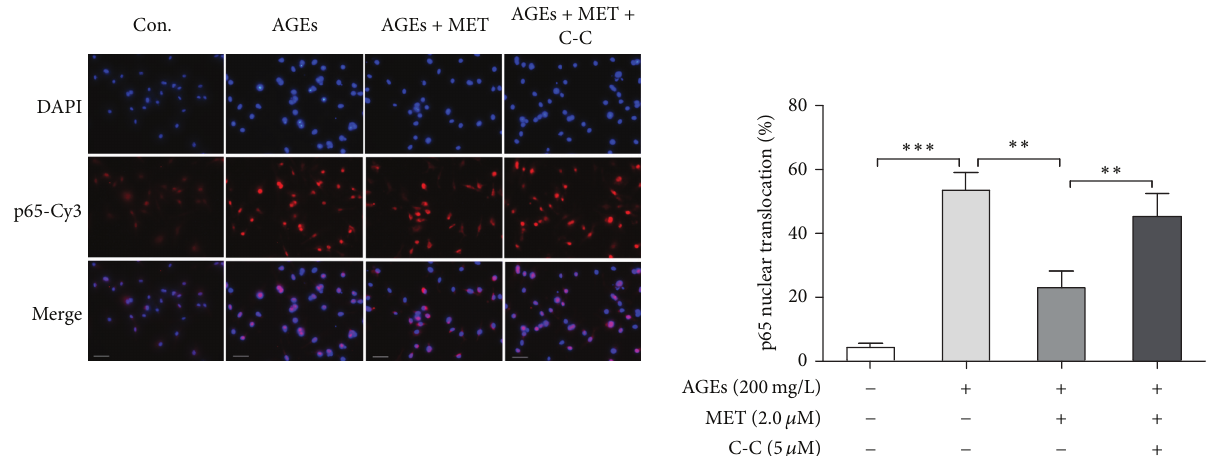
Figure 4: Metformin’s inhibition on AGEs-induced NF 𝜅 B signaling is AMPK dependent. BMDMs were divided into 4 groups: control, AGEs, AGEs + MET, and AGEs + MET + CC group. In AGEs group, cells were cultured with AGEs at 200 mg/L for 60min; in AGEs + MET group, cells were pretreated with metformin for 60 min and then cultured with AGEs at 200 mg/L for 60 min; in AGEs + MET + C-C group, cells were pretreated with Compound C, an AMPK inhibitor, at 5 𝜇 M for 60 min, and then they were treated with metformin at 2.0 𝜇 M for 60 min followed by AGEs at 200 mg/L for 60min; in control group, cells were cultured with BSA at 200 mg/L for 60min. p65 nuclear translocation of each group was evaluated by immunofluorescent staining. Primary antibodies against p65 and Cy3 (red) labeled secondary antibodies were used to detect p65; DAPI (blue) was used to stain the nucleus. Bar graphs represent the results (mean ± SD) of three independent experiments. Bar = 50 𝜇 m. One-way ANOVA was applied and the overall ANOVA was significant. ∗∗ 𝑝 < 0.01 and ∗∗∗ 𝑝 < 0.001 when compared between selected